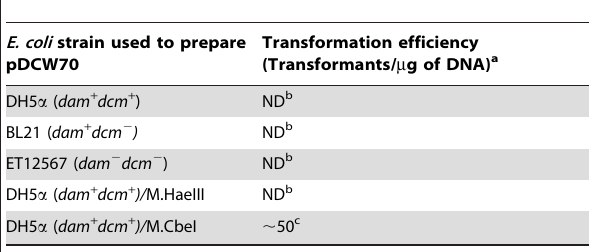
Table 2. Influence of methylation on transformation efficiency of